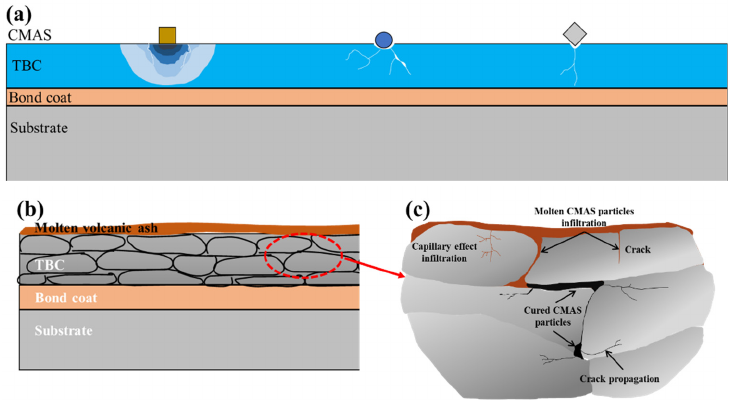
Figure 13. ( a ) Failure modes of coating caused by different forms of particles erosion, ( b ) the molten CMAS particles are deposited onto the TBCs, ( c ) infiltration of the molten CMAS particles in the TBCs after erosion